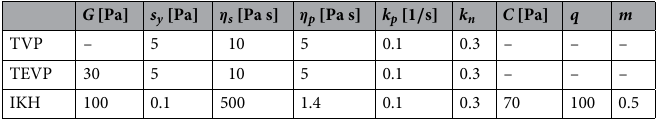
Table 1. Values of the model parameters used for the flow curves presented in Fig.